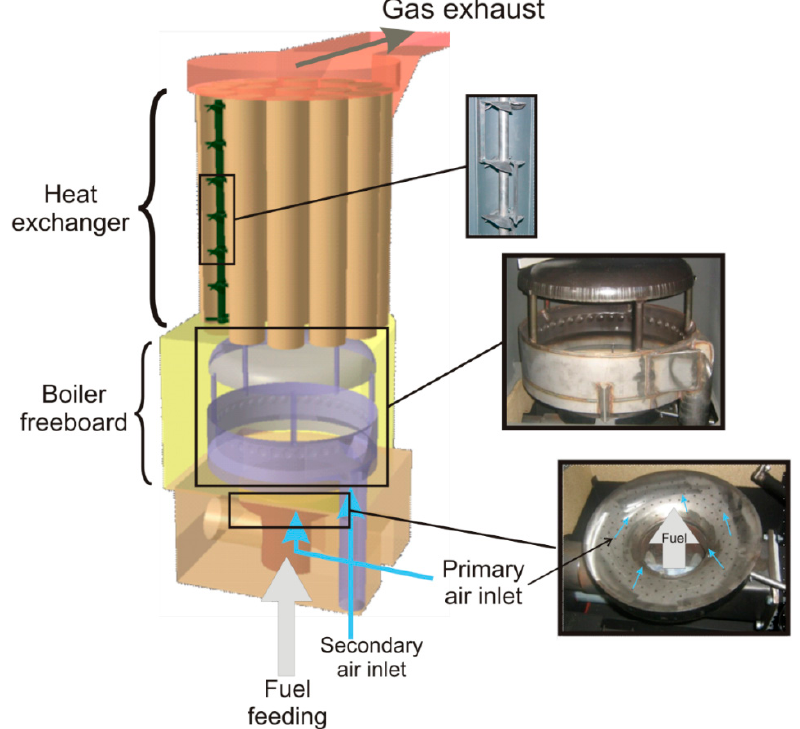
Figure 3. Scheme of the commercial boiler used in the experiments.